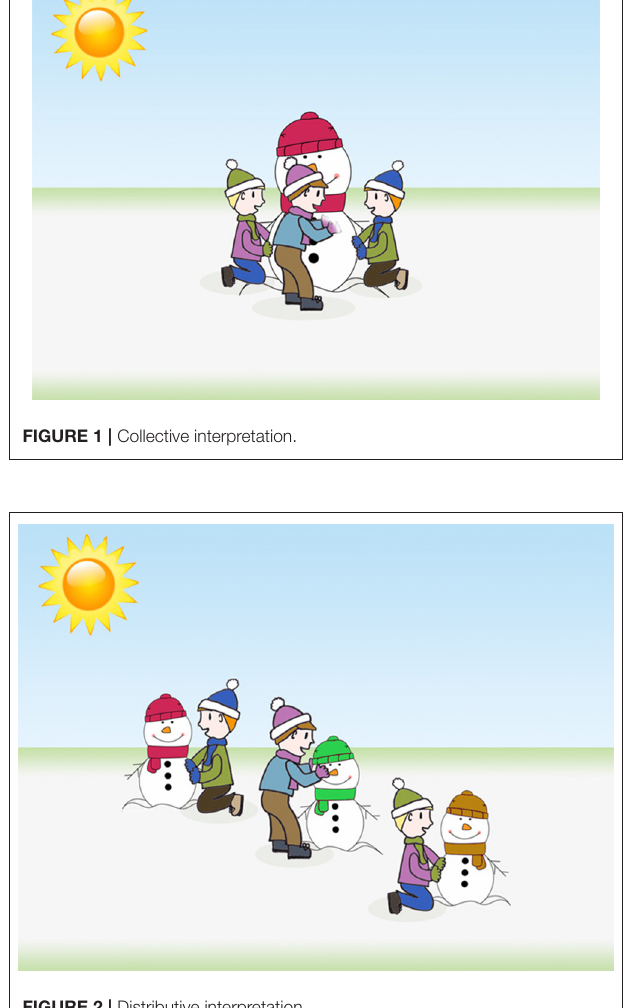
FIGURE 2 | Distributive